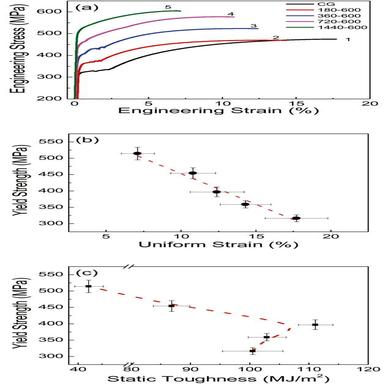
(a) Dependence of Vickers microhardness on the radius of LA steel subjected to PTA treatments and its CG counterpart, (b) Evolution of Vickers microhardness of the 1440-600 sample with tensile deformation.